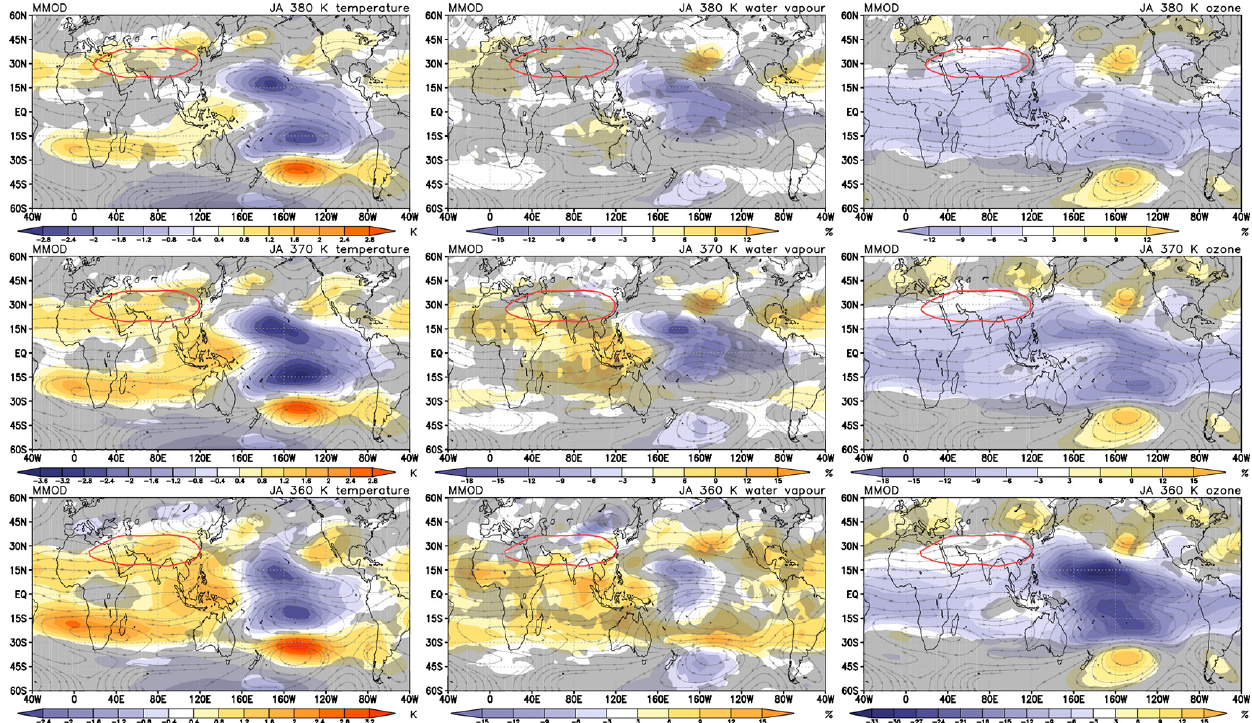
Figure 10. As Fig. 9 but for the Niño3.4